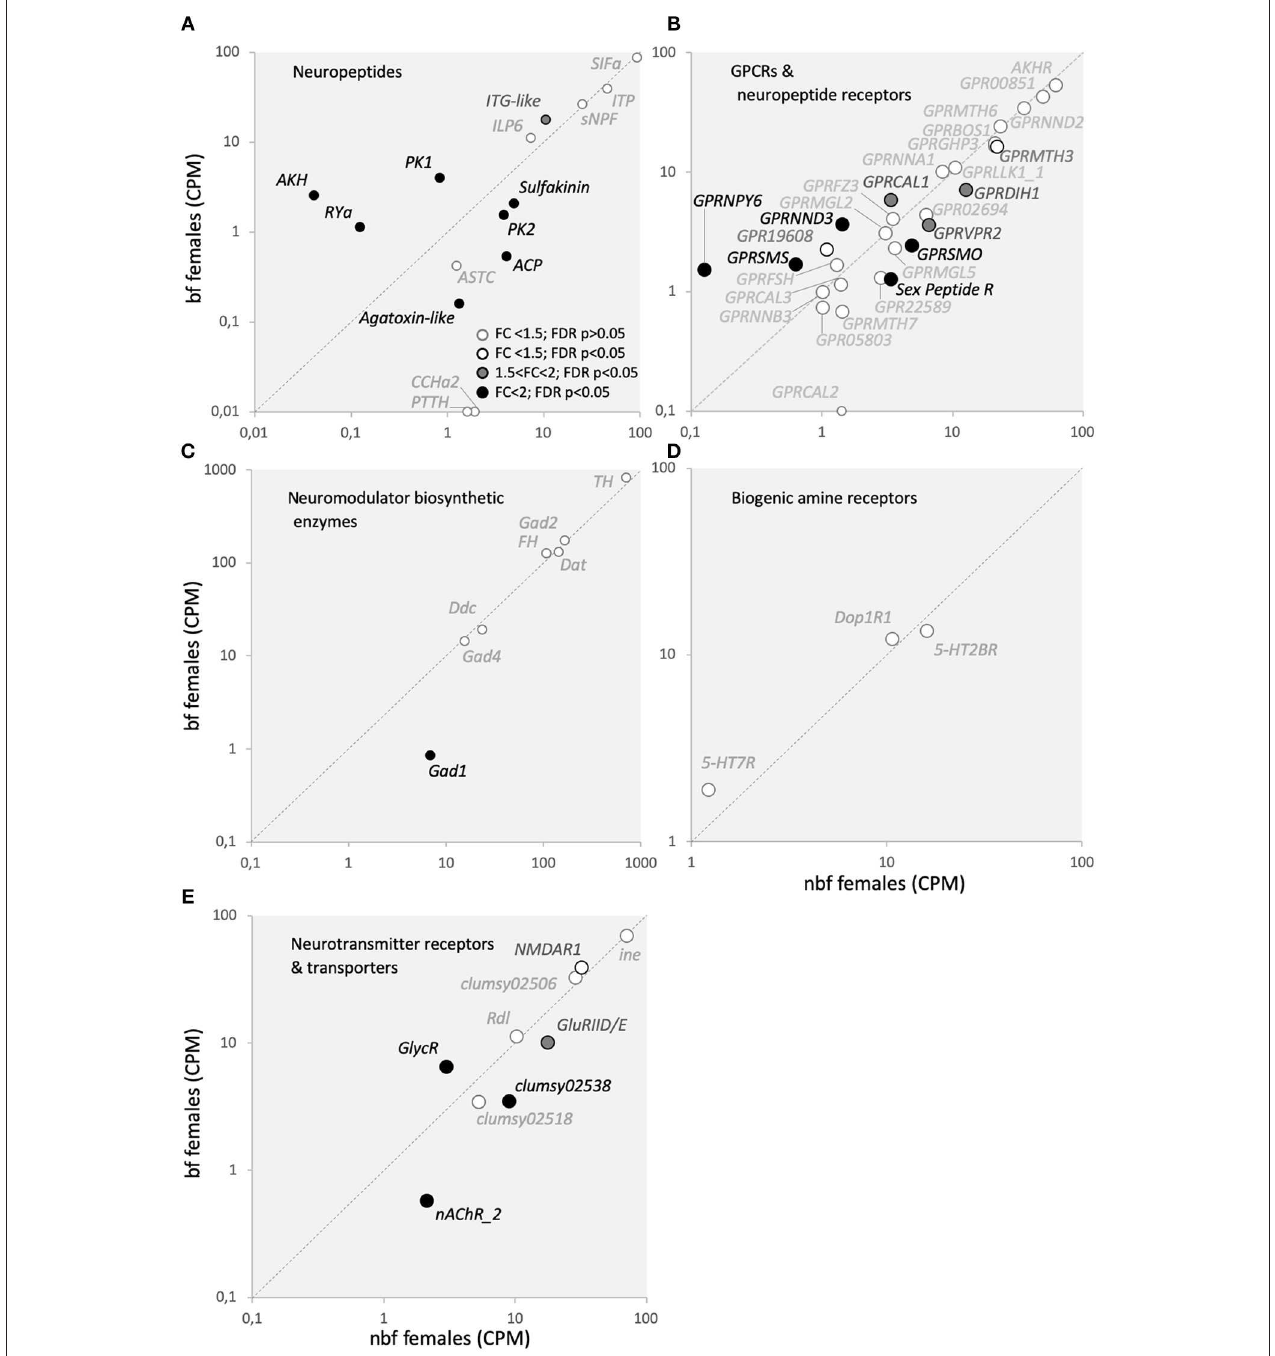
FIGURE 7 | Neurotransmitters and modulators with their cognate receptors, transporters, and biosynthetic enzymes transcript abundance. Transcript regulation in the maxillary palps of blood fed (bf) and non-blood fed (nbf) Aedes aegypti females is presented as the normalized number of reads of (A) neuropeptides, (B) GPCR and neuropeptide receptors, (C) neuromodulator biosynthetic enzymes, (D) biogenic amine receptors, (E) neurotransmitter receptors and transporters. Transcripts that exhibit significant differences in abundance (Kal’s test; FDR P < 0.05), are denoted according to their fold change (FC); FC > 2 in black-filled circles; 1.5 < FC < 2 in gray-filled circles; and FC < 1.5 in unfilled circles. The gray dotted line indicates a hypothetical equal transcript abundance between the states. (A) SIFamide ( SIFa ; AAEL009858); ion-transport peptide ( IPT ; AAEL019725); short neuropeptide F ( sNPF ; AAEL012542); ITG-like peptide (ITG-like; AAEL010262); insulin-like peptide 6 (ILP6; AAEL004547); sulfakinin (sulfakinin; AAEL006451); adipokinetic/corazonin peptide (ACP; AAEL010950); pyrokinin 2 ( PK2; AAEL005444); CCHamide 2 (CCHa2; AAEL026488); prothoracicotropic hormone (PTTH; AAEL026383); Agatoxin-like neuropeptide (Agatoxin-like; AAEL022190); allatostatin C ( ASTC ; AAEL005747);